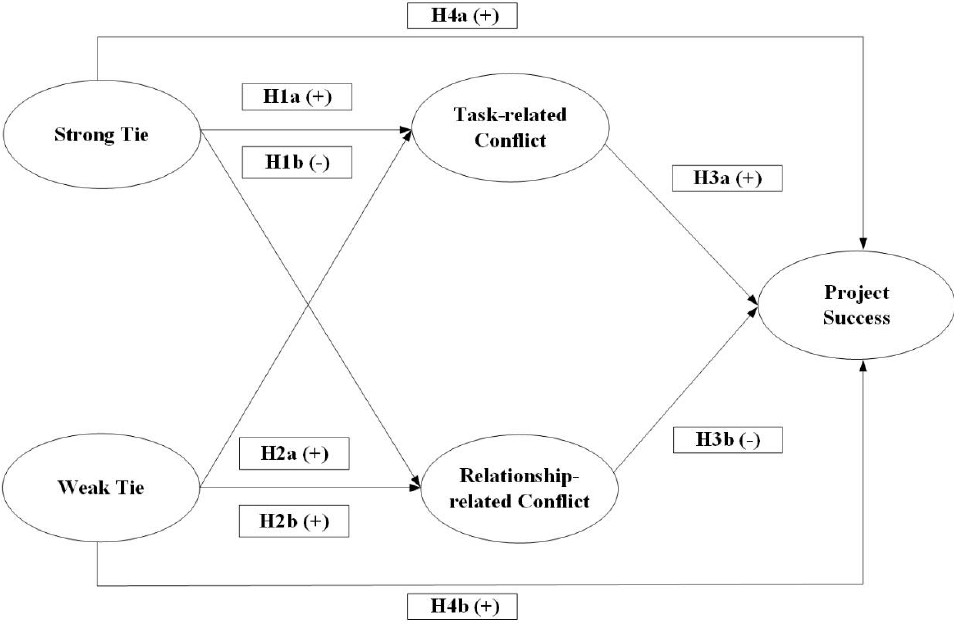
Figure 1. Theoretical